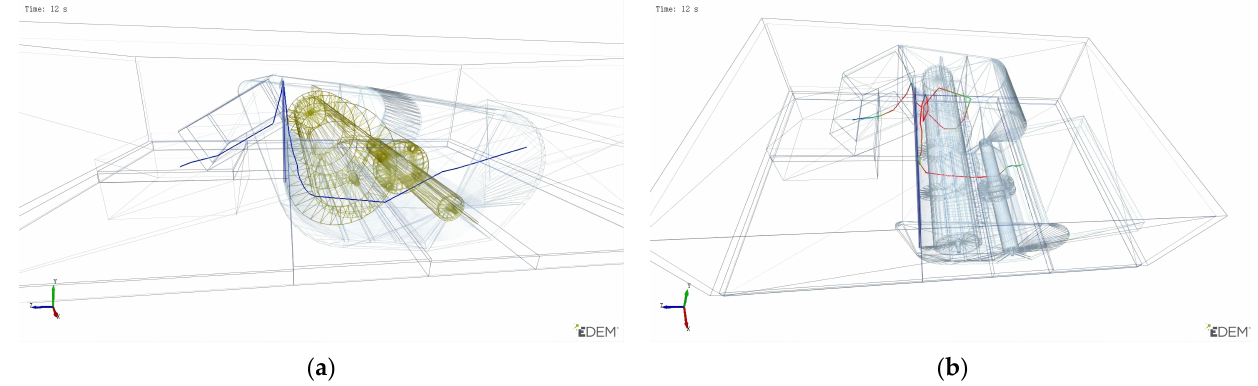
Figure 12. Movement locus: ( a ) movement locus of tiger nut; ( b ) movement locus of tiger nut root.